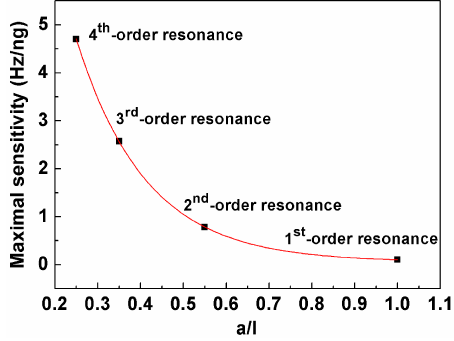
Figure 6. The maximal sensitivity as a function of mass load distribution ( a / l ).